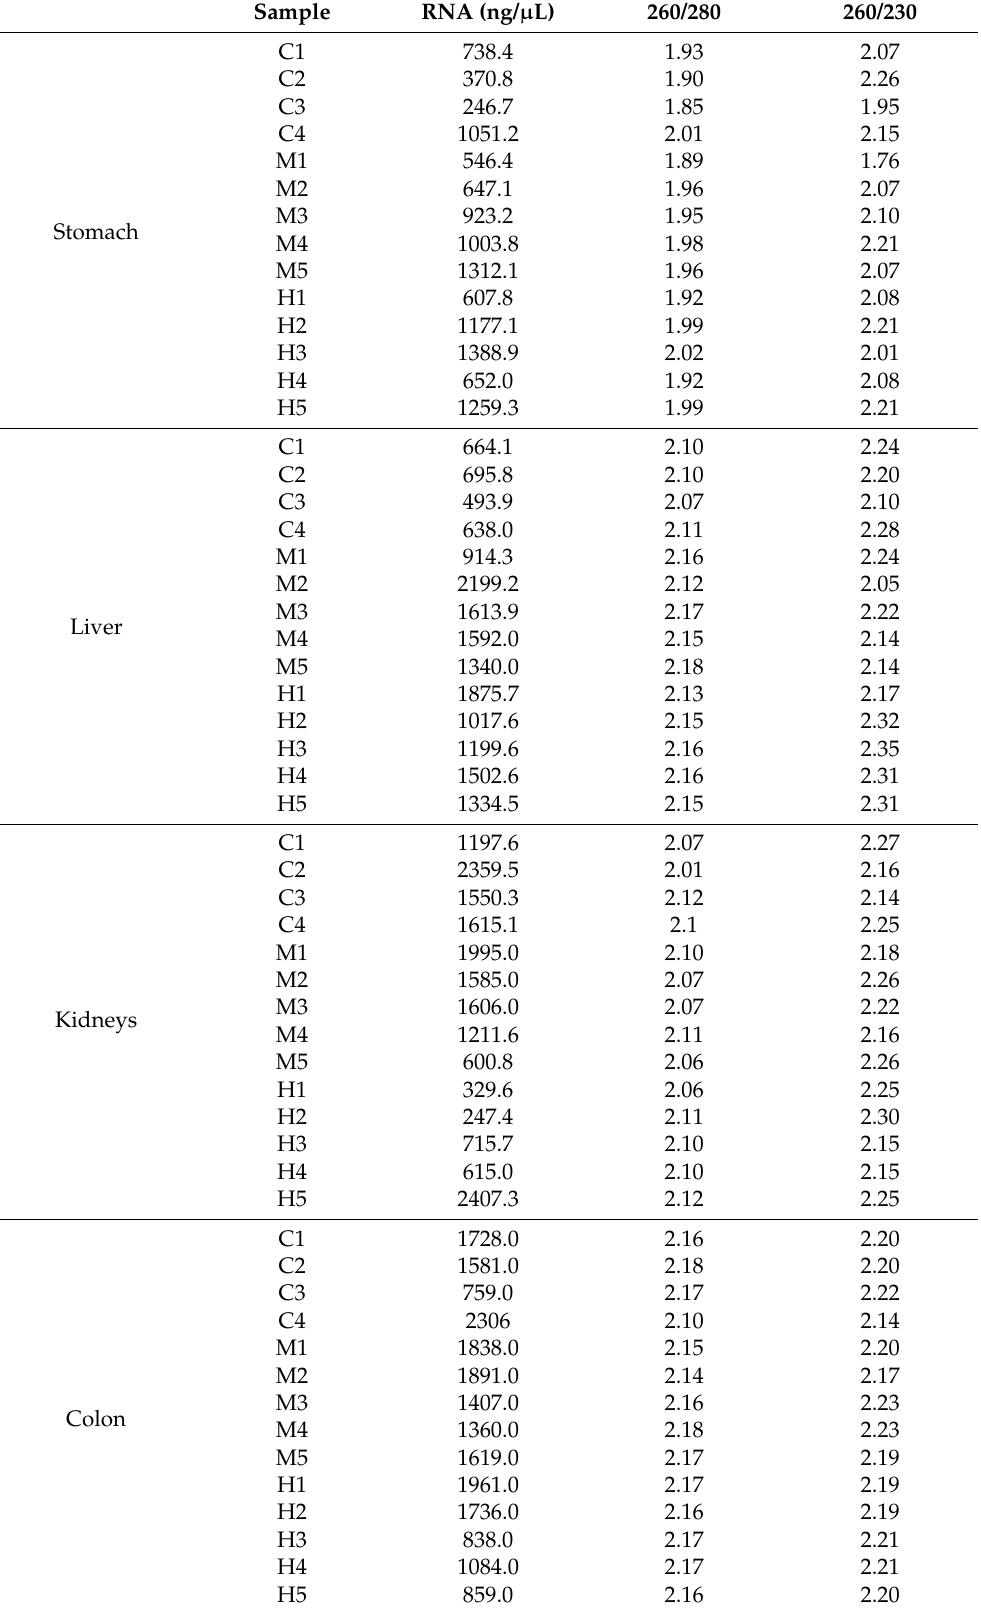
Table 1. Target organ samples: control (C), medium dose (M), high dose (H) extracted RNA concen- tration (ng/ µ L), RNA purity ratios 260/280 and